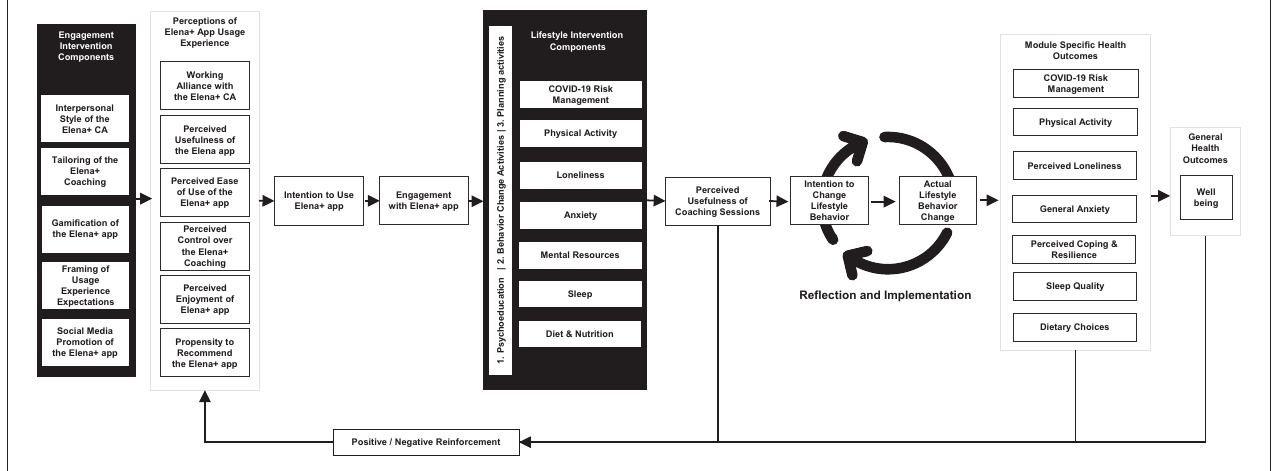
FIGURE 1 | Elena + conceptual